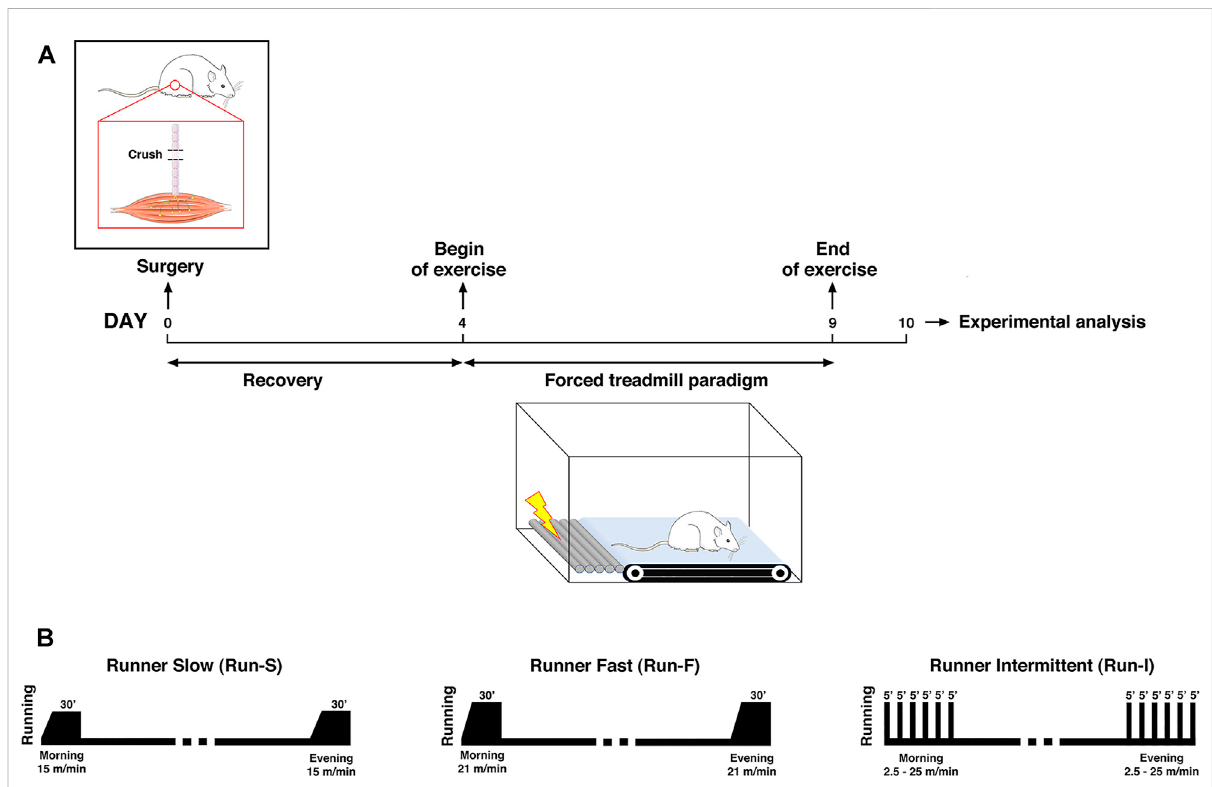
FIGURE 1 Schematic representation of the experimental design for assessing the exercise-induced effect on muscle re-innervation after nerve-crush (A) and exercise protocols used (B)